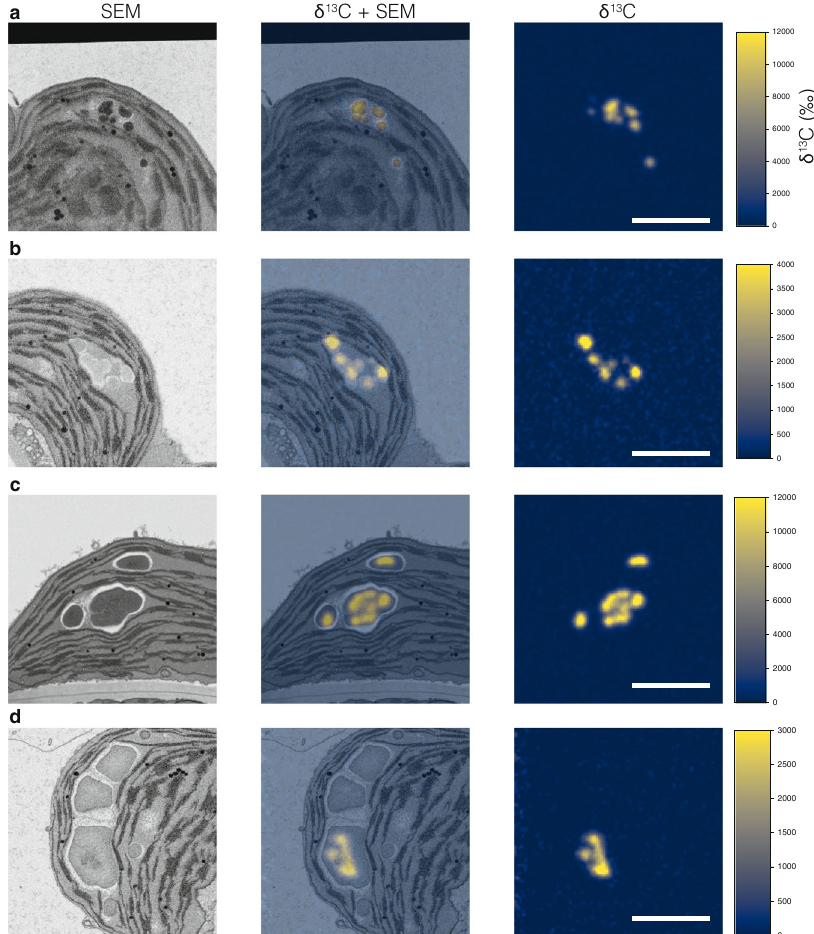
Fig. 3 Coalescence of starch granule initials tracked with stable isotope labeling, EM, and NanoSIMS imaging. Plants subjected to a 4-h night extension were labeled with a pulse of 13 CO 2 for 15 min in the light, then harvested immediately ( a ), or after a chase of 15 min ( b ), 45 min ( c ), or 4 h ( d ) in normal air in the light. In each case, samples were fi xed and embedded for EM and NanoSIMS imaging. The electron micrograph (left, inverted SEM image) and the enrichment map (right), and their overlay (center) are shown. The 13 C-enrichment is reported as per mille. Note the multiple labeled initials in each stromal space, with an increasing degree of coalescence during the chase in normal air. Scale bar: 2 µ